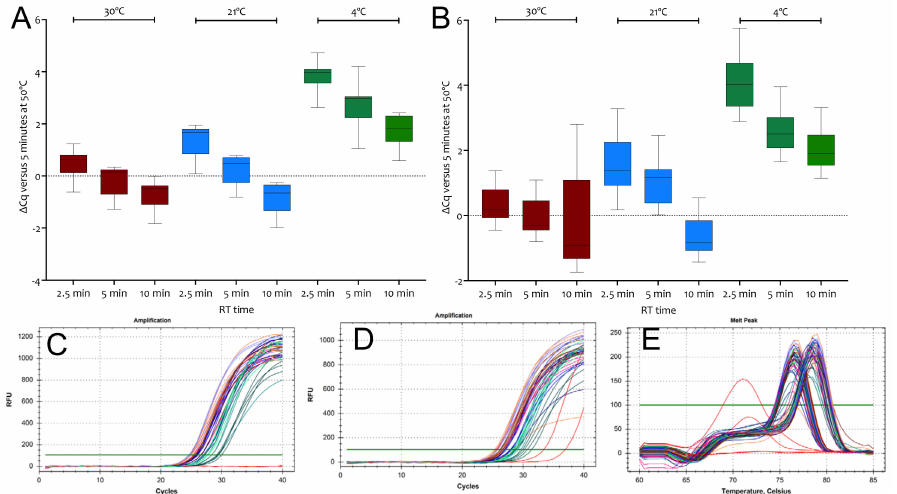
Figure 4. ∆ Cq values recorded for RT reactions carried out at for 2.5, 5 or 10 min at 30 ◦ C (brown), 21 ◦ C (blue) or on ice (green) relative to 5 min RT reactions at 50 ◦ C. ( A ) Cq values recorded for assay E1. ( B ) Cq values recorded for assay N1. ( C ) Amplification plots for E1. The NTCs (red) did not record Cqs. ( D ) Amplification plots for N1. Both NTCs recorded Cqs (red). ( E ) Melt curves for E1 and N1. The two positive NTCs display melt curves different from those obtained for assay N1. All box and whiskers plots show the ∆ Cqs for the independent RT-qPCR reaction, with the whiskers delineating the minimum and maximum